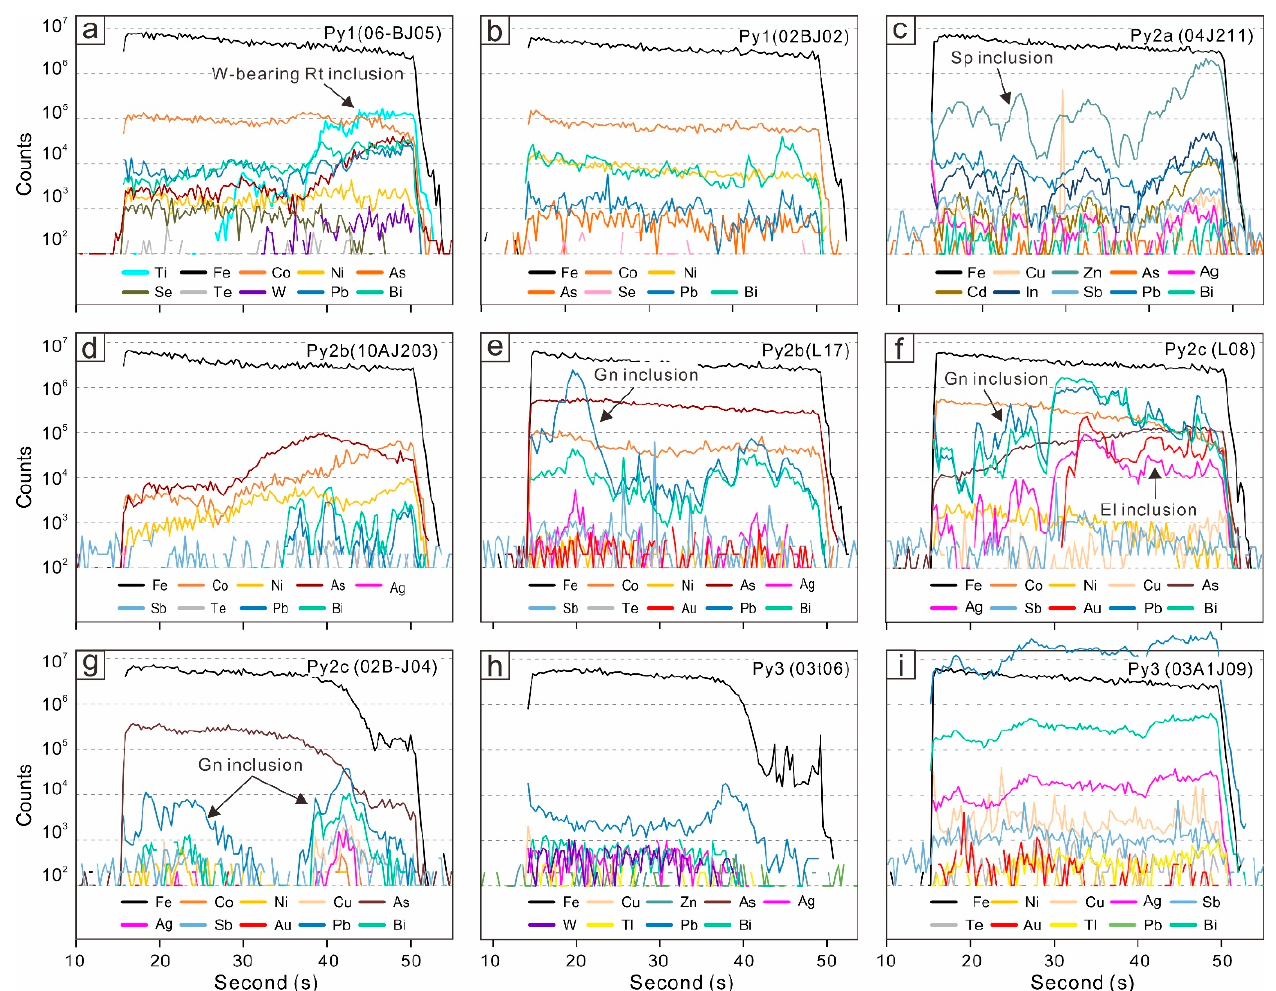
Figure 9. Representative time-resolved depth profiles of LA–ICP–MS analyses of pyrite (Py1: a,b , Py2a: c , Py2b: d,e , Py2c: f,g , and Py3: h,i ) from the Sizhuang gold deposit. El electrum; Gn galena; Rt rutile; Sp sphalerite.